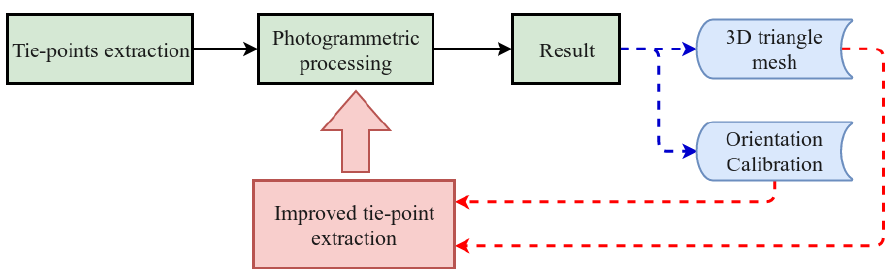
Figure 1. A second iteration processing with refined